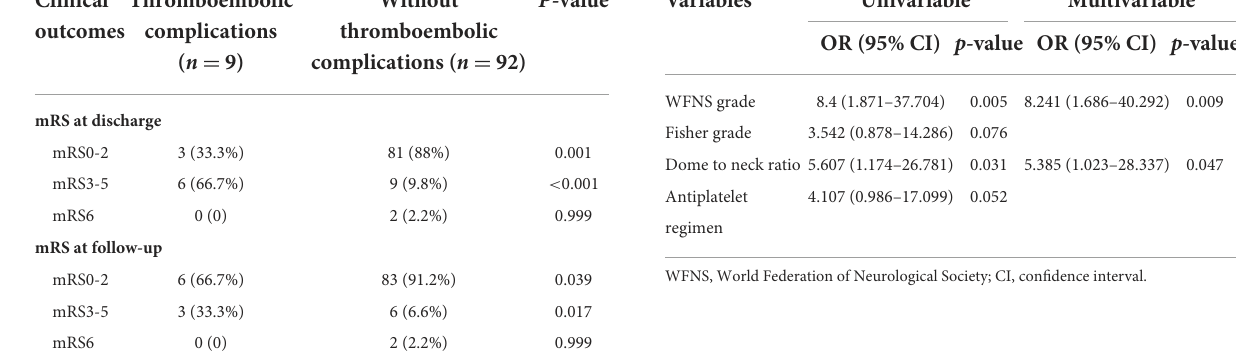
TABLE 2 Clinical outcomes between patients with thromboembolic complications and those without complications. Clinical outcomesThromboembolic complications